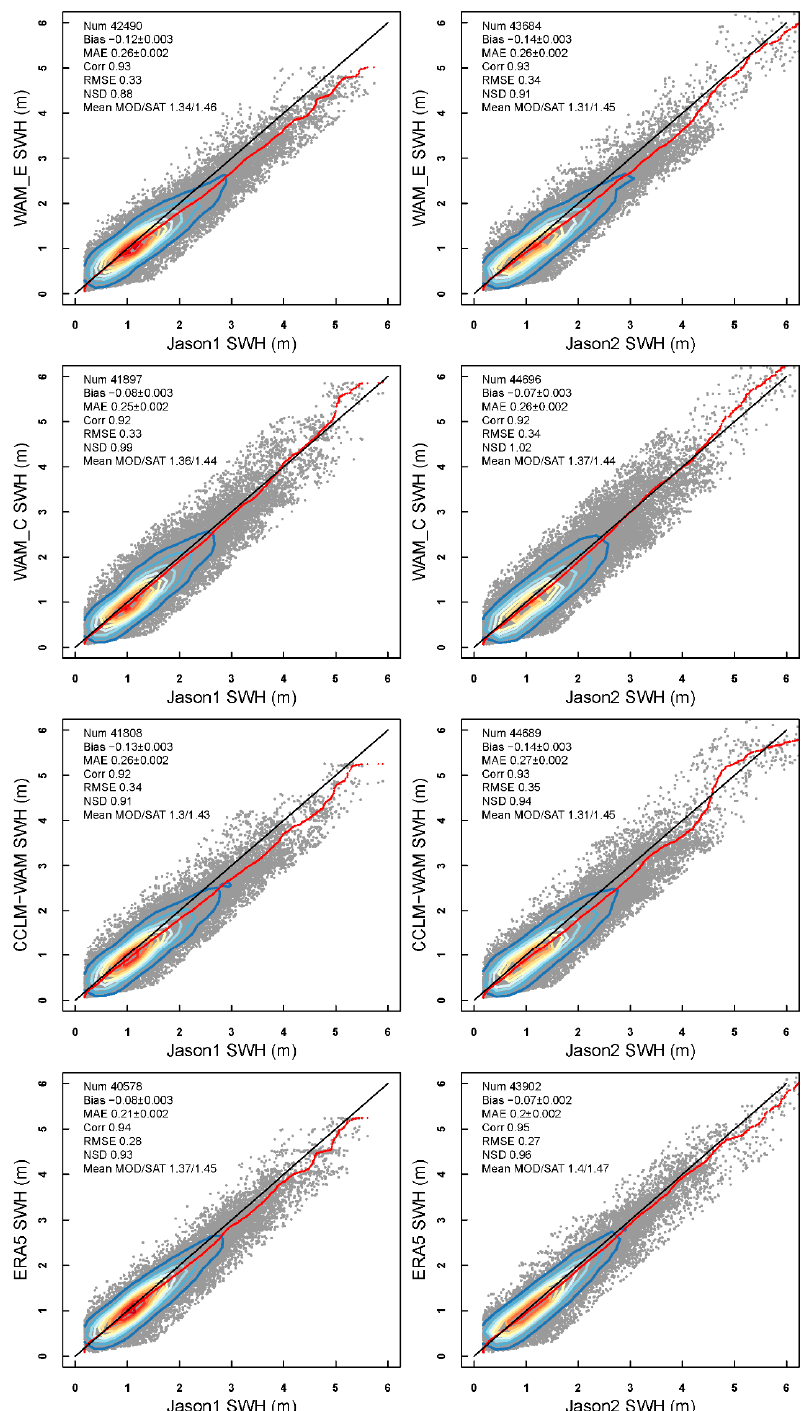
Figure 8. The same as Figure 7, but for significant wave height (SWH).